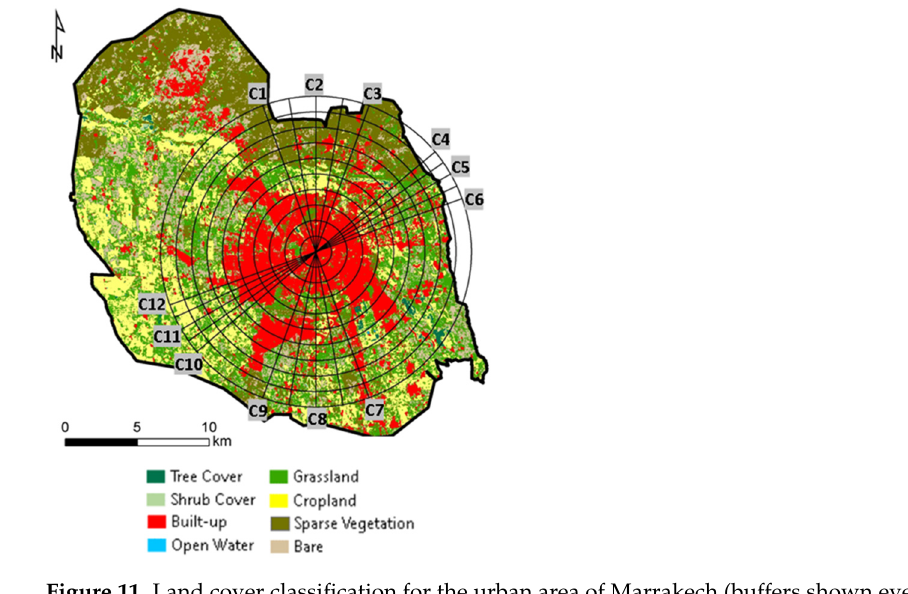
Figure 12. Surface temperature cross section along a north-south transect across the city of Marrakech.